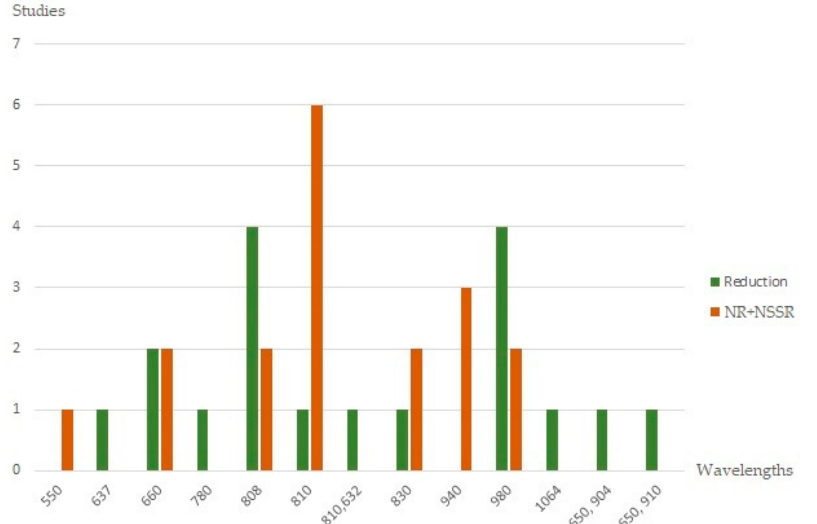
Figure 3. Histograms showing the swelling outcome according to the wavelengths of the included studies. Legend: NR, no reduction, NSSR, no statistically significant results.